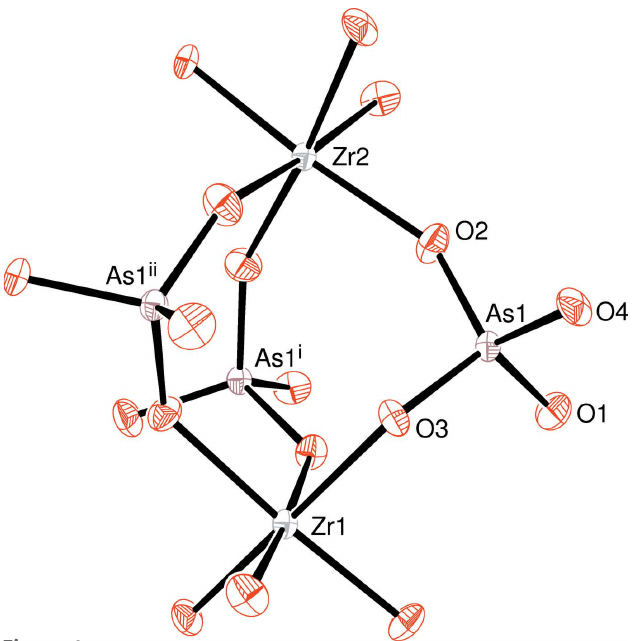
Figure 4 Detail of the extended structure of (I) showing a Zr 2 As 3 O 18 ‘lantern’ motif of Zr1 and Zr2 octahedra linked by three As1 tetrahedra via atoms O2 and O3. In (I), this motif has crystallographically imposed threefold symmetry about a rotation axis passing through the zirconium atoms. Symmetry codes: (i) 1 (cid:2) y , 1 + x (cid:2) y , z ; (ii) y (cid:2) x , 1 (cid:2) x , z .